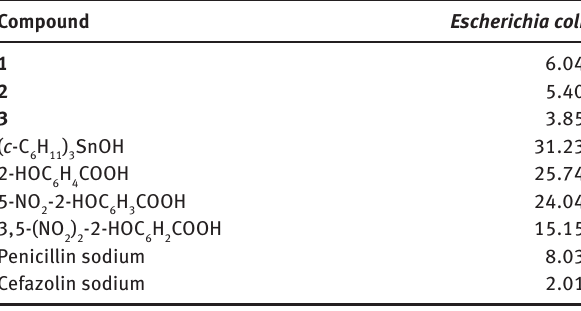
Table 3: Antibacterial activity (MIC, μ g mL -1 ) of the compounds.